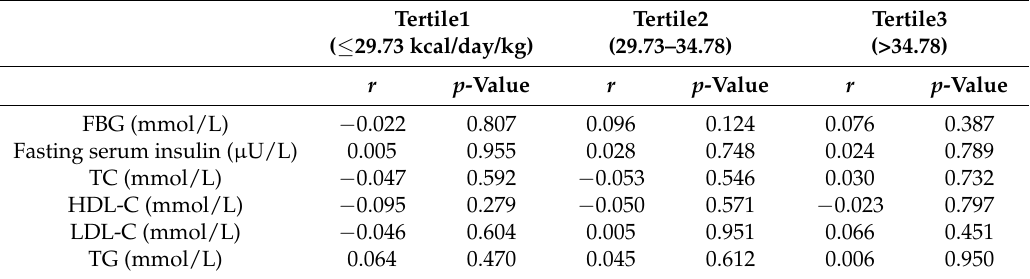
Table 6. Partial correlation coefficients between glycolipid metabolism and the tertiles of REE/FFM.